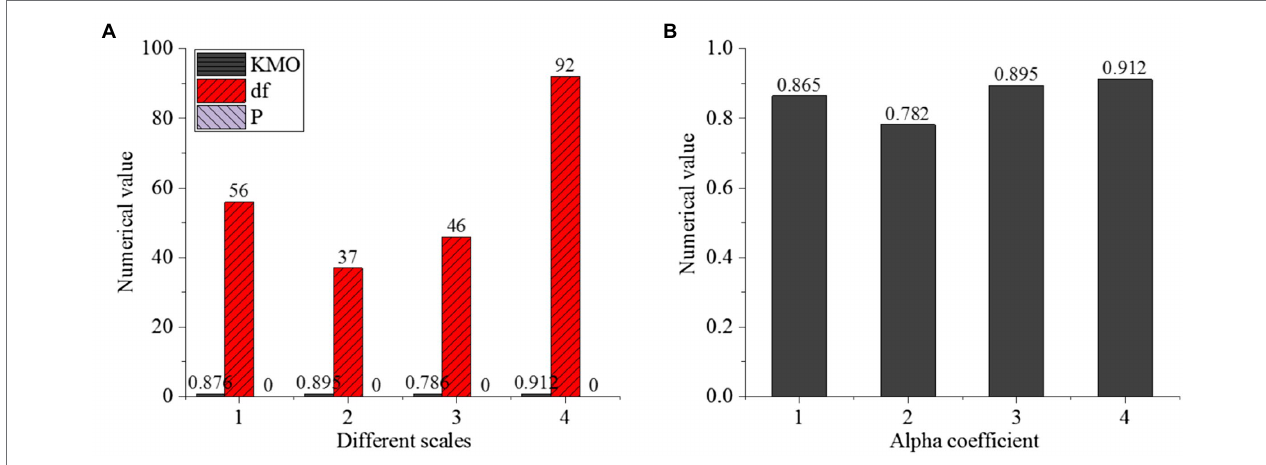
FIGURE 6 | Validity test of research scales ( A : different scales with Numerical value, B : Alpha coefficient with Numerical value, A: Cross-cultural competency scale, B: Cross-cultural adaptation scale, C: Entrepreneurial intention scale, D: Psychological adaptation scale of venture entrepreneurs). TABLE 5 | The correlation between the variables. Cross-cultural competency Cross-cultural adaptation Entrepreneurial intention Psychological adaptation Cross-cultural competency 1 Cross-cultural